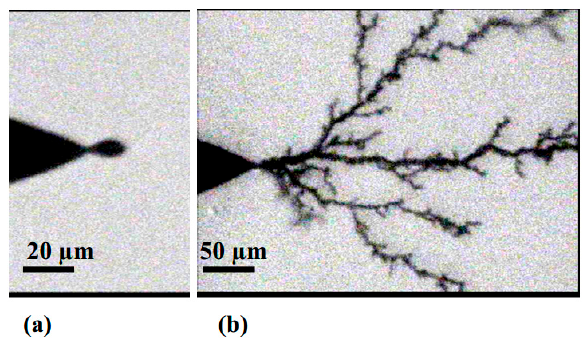
Figure 13. Shadow photographs of slow streamer and fast filamentary streamer [88]. ( a ) Applied voltage is 13 kV, ( b ) applied voltage is 17 kV.